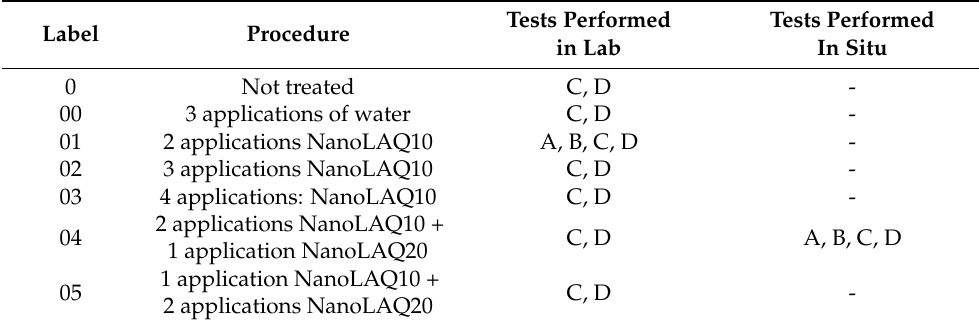
Table 1. Application procedures and concentrations considered in the laboratory